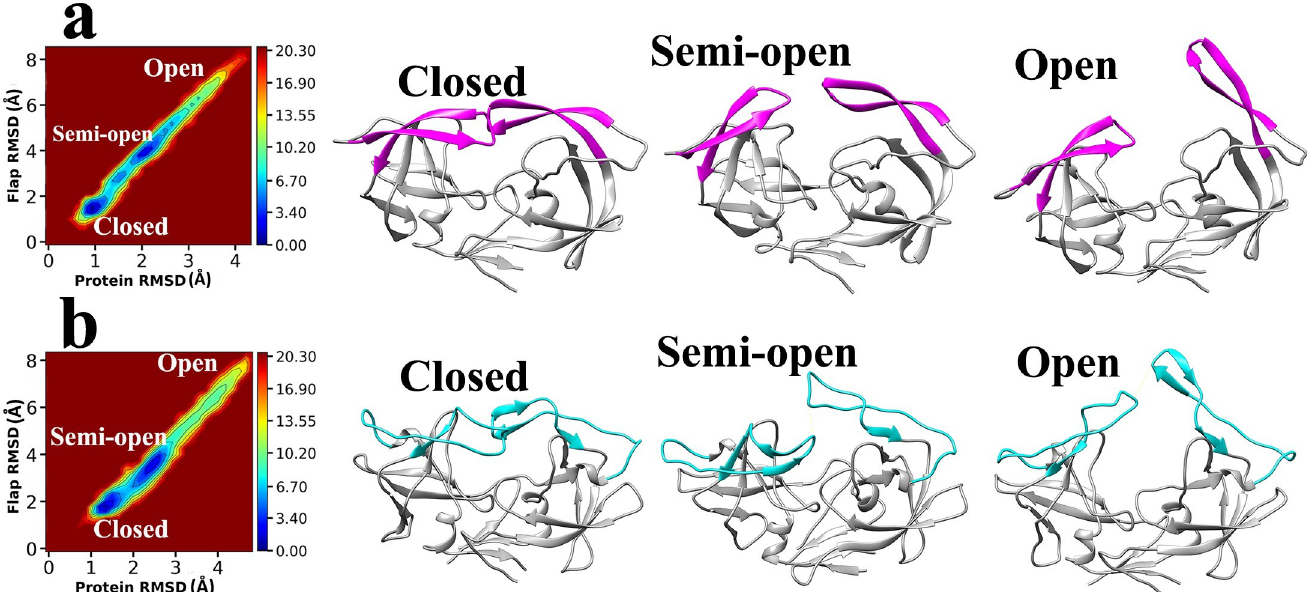
Fig 7. The main conformational states of the flap region were acquired during the unbinding pathways of Indinavir. a, The “out-of-equilibrium” free energy landscape and the 3D structures of HTLV-1 protease with different flap states. b, The “out-of-equilibrium” free energy landscape and the 3D structures of HIV protease with different flap states.